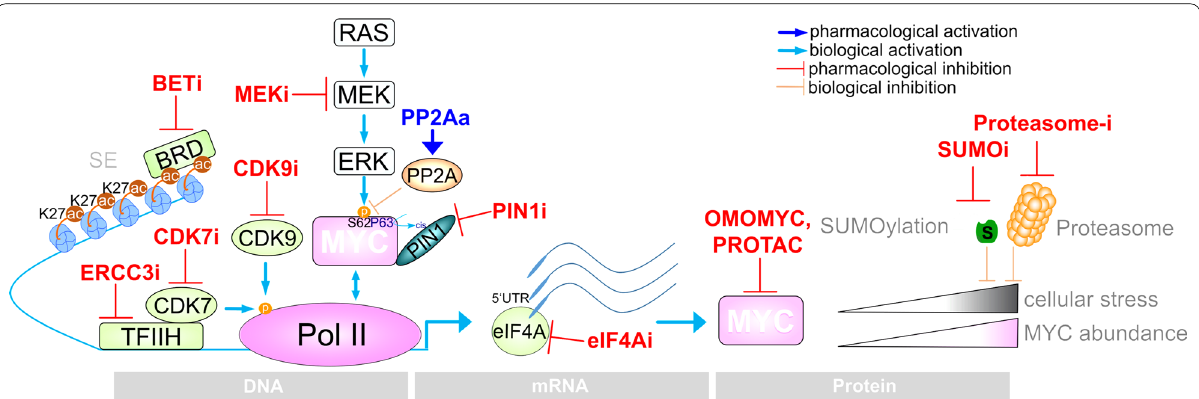
Fig. 1 Targeting of MYC. Illustrated are options of direct or indirect MYC inhibition by pharmacological inhibitors or activators, respectively. Indirect inhibition is achieved by interfering with transcription, translation. The concept to target MYC by synthetic lethality in PDAC is shown. Direct inhibition by a synthetic OMOMYC peptide or possibly by PROTACs renders the MYC protein itself nonfunctional. SE Super enhancer, BRD Bromodomain